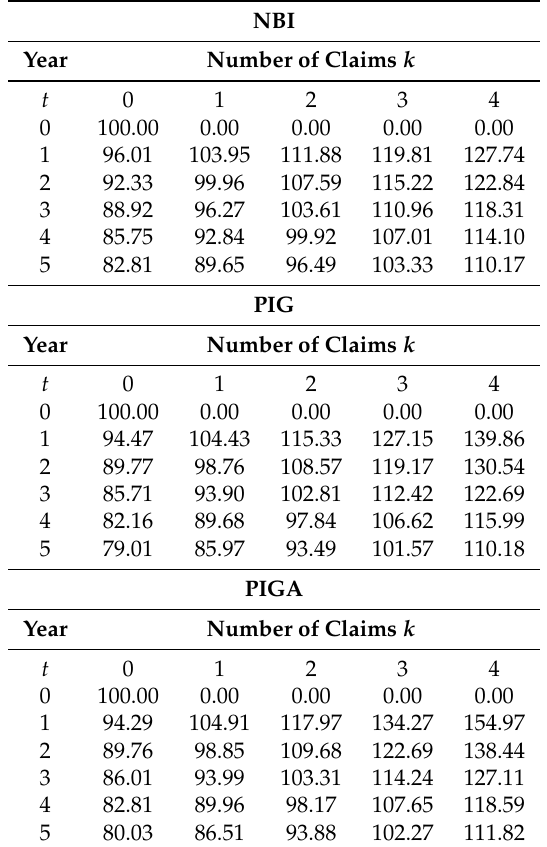
A Posteriori, or Bonus-Malus, premiums for risk class 2, regression models with varying